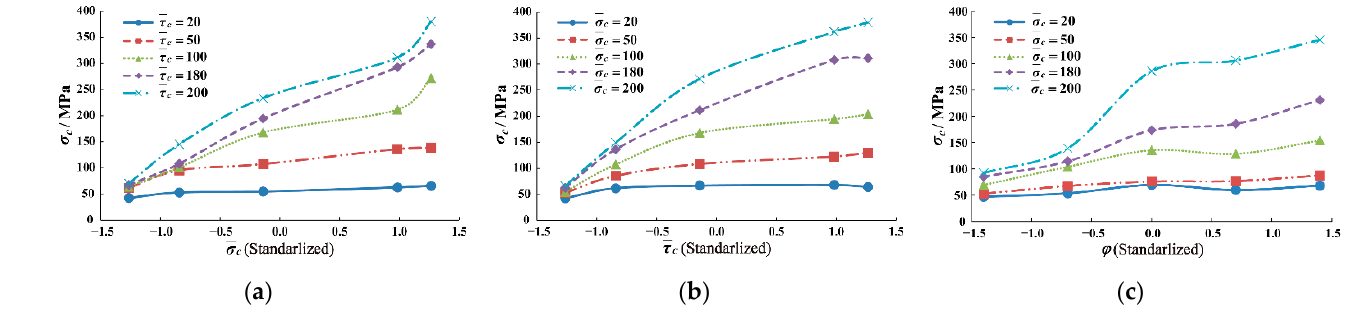
Figure 13. Joint effect of multiple meso parameters on peak strength: ( a ) Tensile and shear strengths of parallel bond; ( b ) Shear and tensile strengths of parallel bond; ( c ) Internal friction angle and tensile strength of parallel bond.